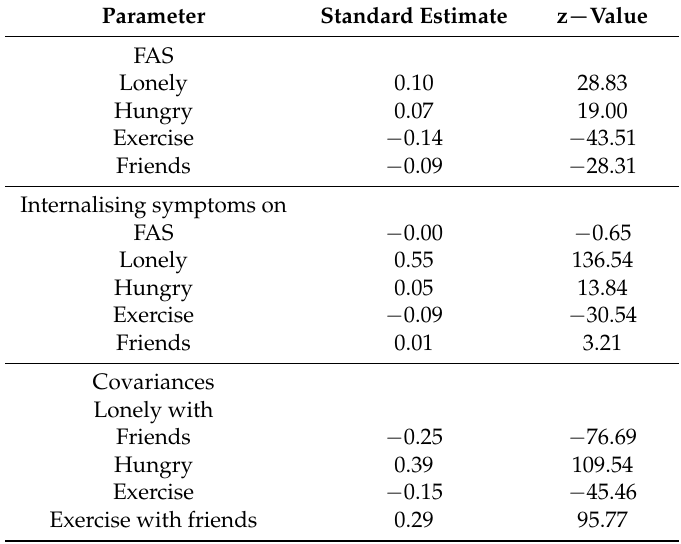
Table 4. Standardised path coefficient estimates of FAS and summer holiday experiences on internalising